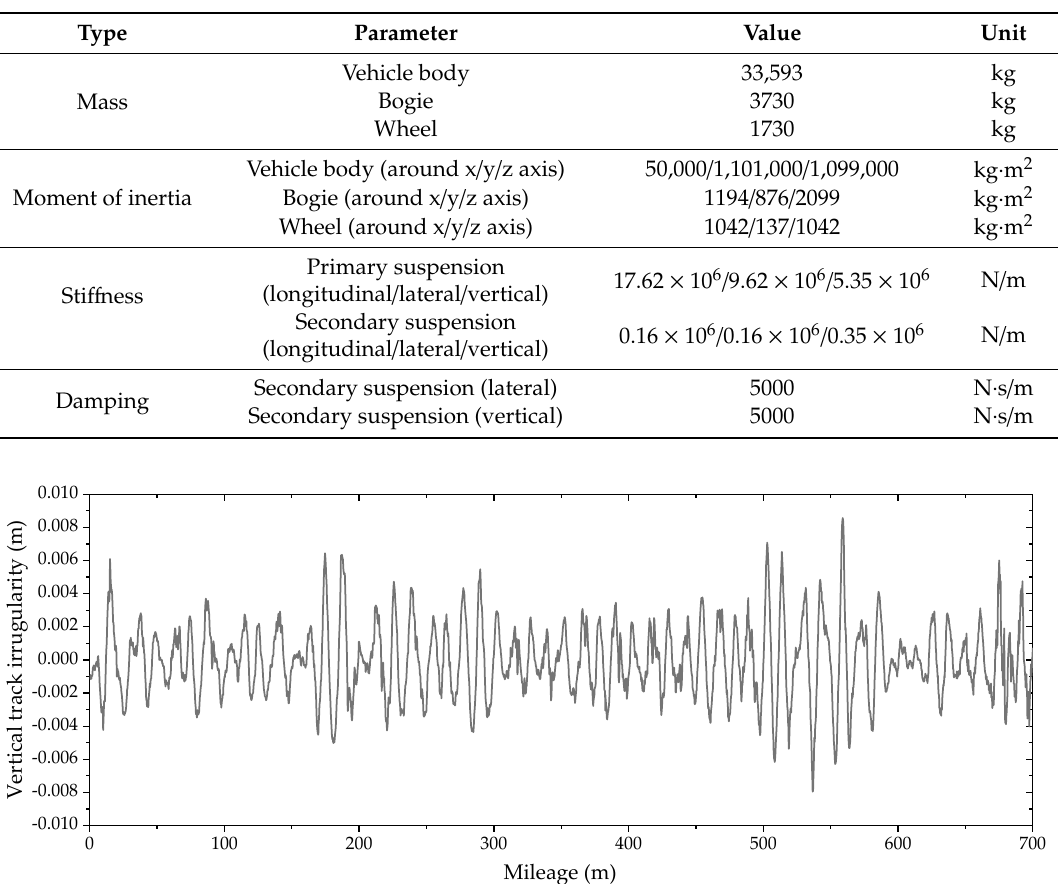
Figure 2. Track irregularity sample.